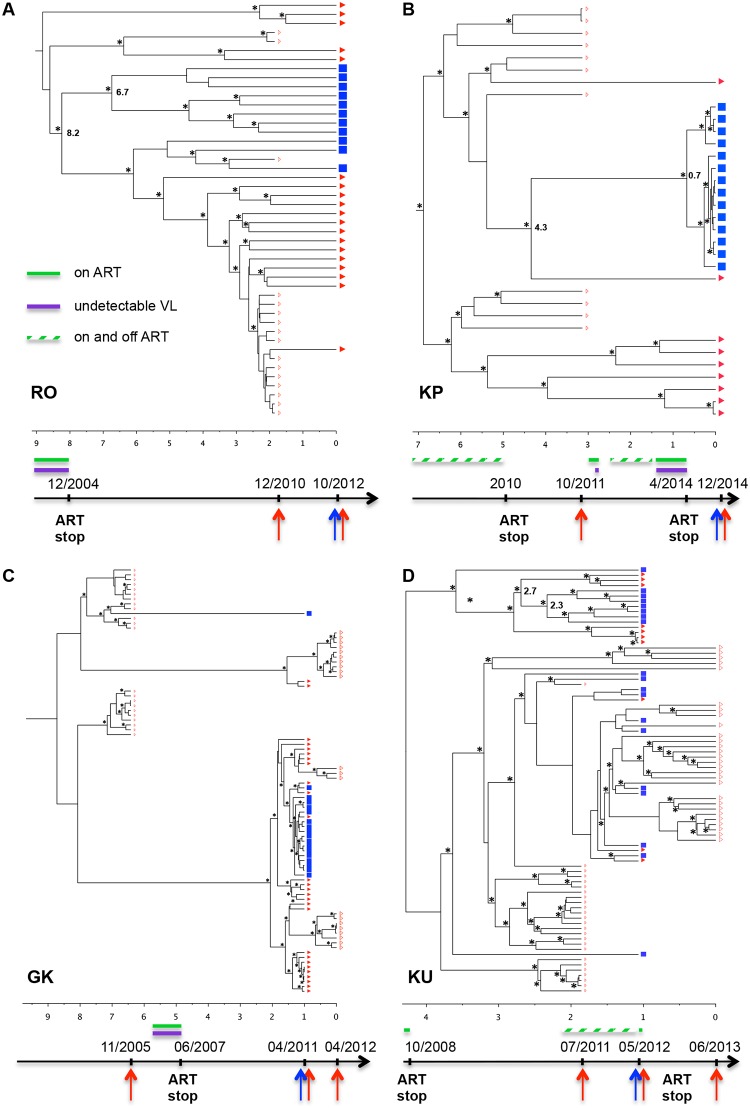
Time scaled Bayesian evolution trees for subjects RO (A), KP (B), GK (C) and KU (D).Blue squares and red triangles (full symbols at time of CSF collection, empty symbols for the other time points) represent CSF and blood plasma derived variants, respectively. Asterisks indicate posterior probability > 0.7 and timescale is in years from the last time point, e.g. the latest sample. A schematic time scale indicating the sampling dates of CSF and plasma (blue and red arrows, respectively), as well as periods of antiretroviral treatment (ART) in green and successful therapy with undetectable viral loads in purple, is shown at the bottom of each Fig. Hatched bars correspond to periods with intermittent treatment and/or poor adherence.